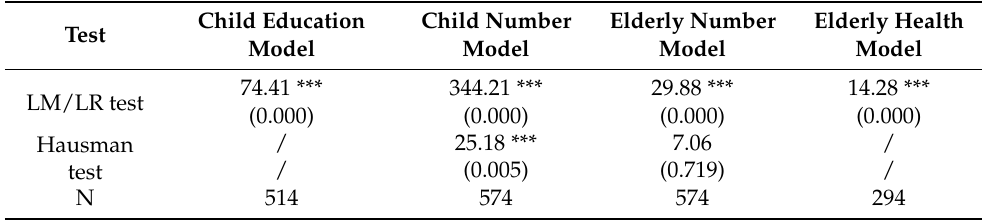
Table 2. LM and Hausman test